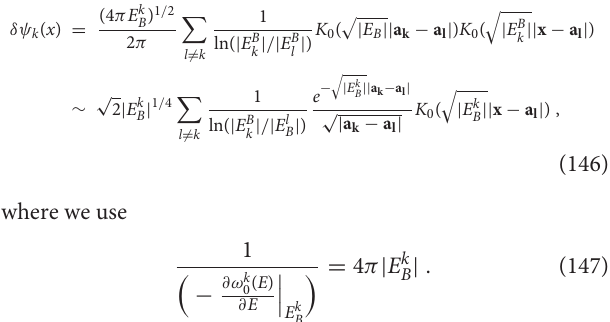
correction will be of lower order as we have seen in the shift of energy